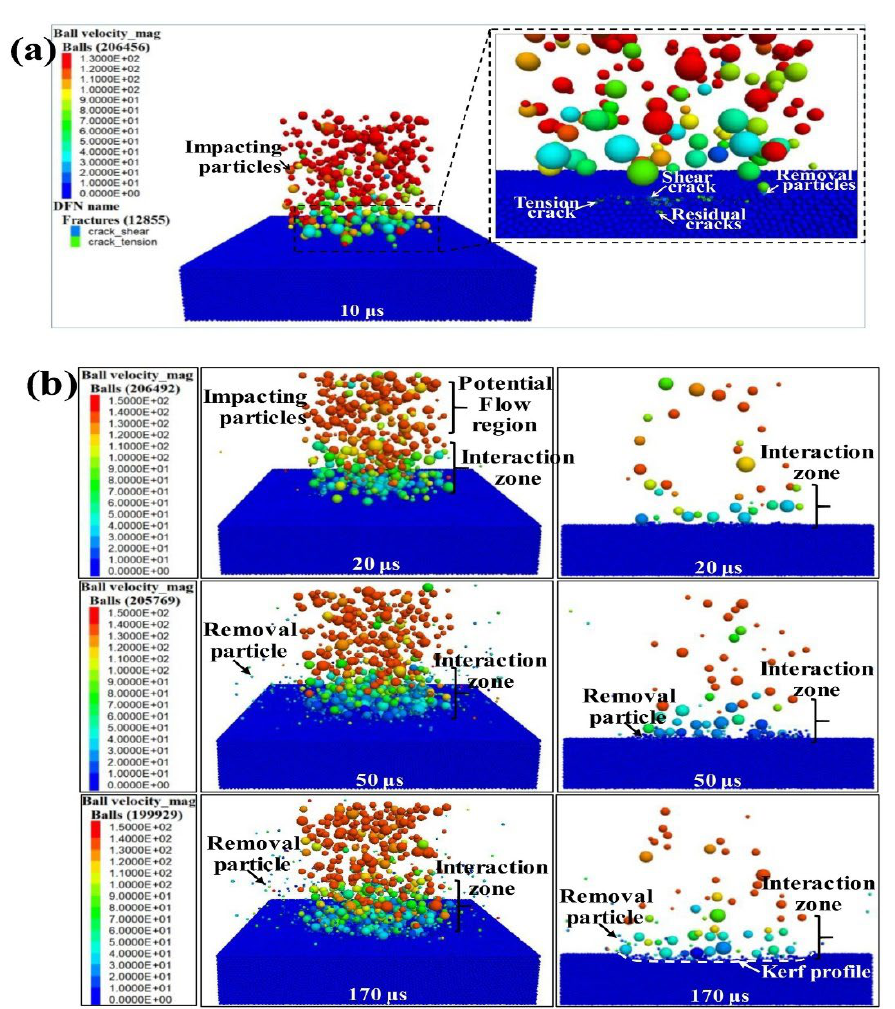
Figure 33. Model setup for the abrasive particle jet against the solid specimen in the DEM simulation [185].